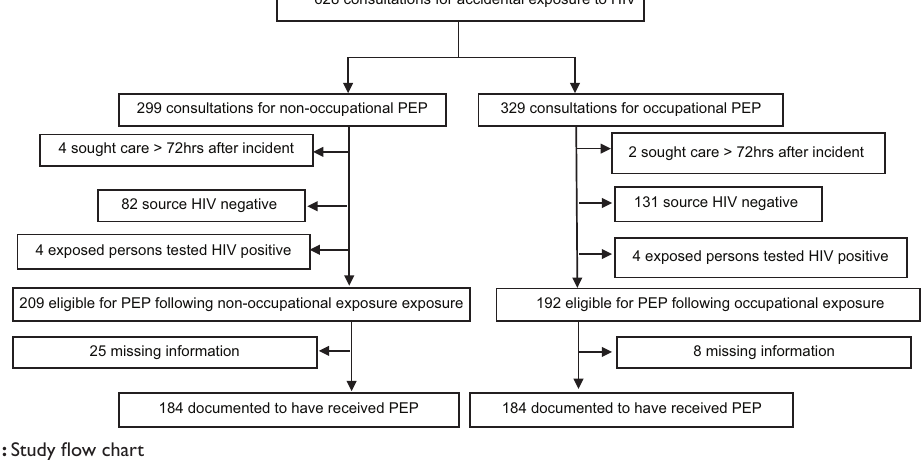
Figure 1: Study flow chart